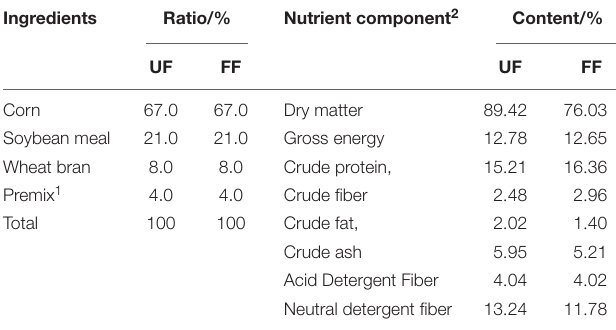
TABLE 1 | Ingredients and nutrient components of the experimental